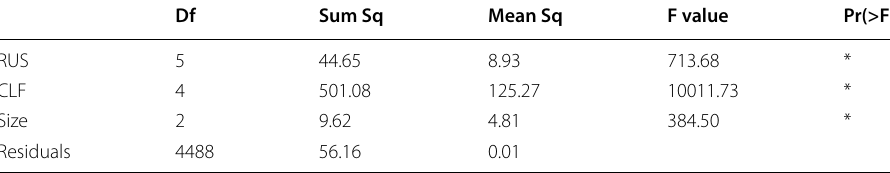
Table 15 ANOVA for RUS, CLF and size as factors of performance in terms of